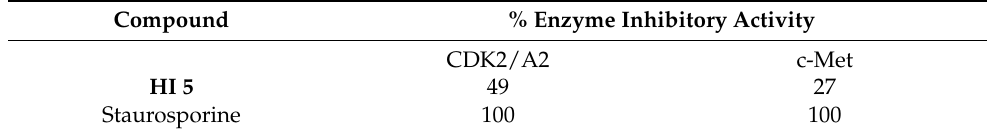
Figure 2. Effects of different concentrations of HI 5 and staurosporine on CDK2/E enzyme activity. HI 5 showed high growth inhibitory activity CDK2/A2 (49%) and moderate (27%) growth inhibitory effect against c-Met at a concentration of 10 µ M (Table 1). Hence, HI 5 exhibited certain selectivity toward CDK2/A2. Table 1. Inhibitory effect of HI 5 on CDK2/A2 and c-Met kinases activity at a single dose of 10 µ M.